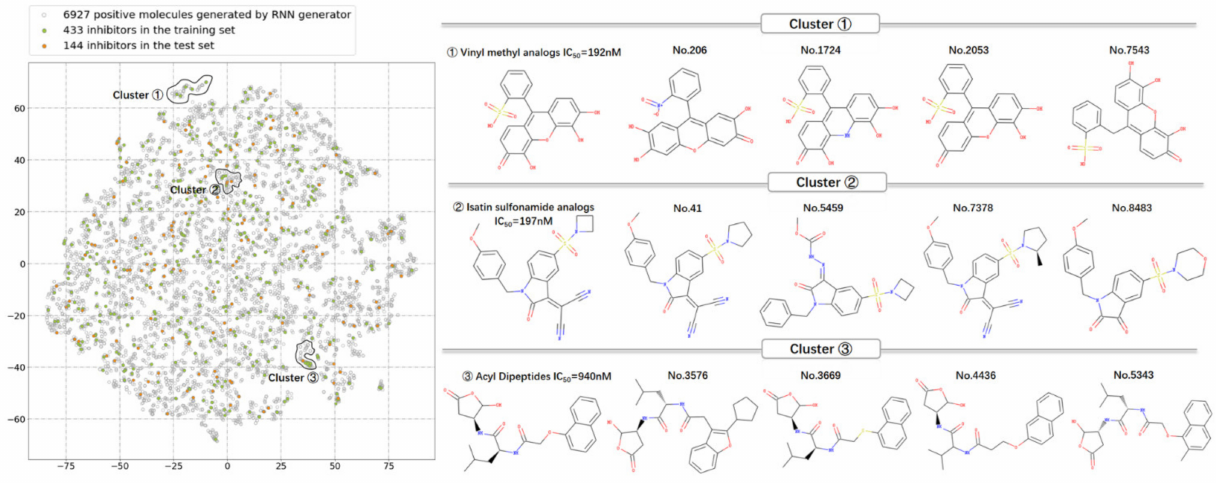
Figure 6. The distribution in the chemical space of the 6927 generated molecules (grey) and 577 known caspase-6 inhibitors (green: training samples; yellow: test